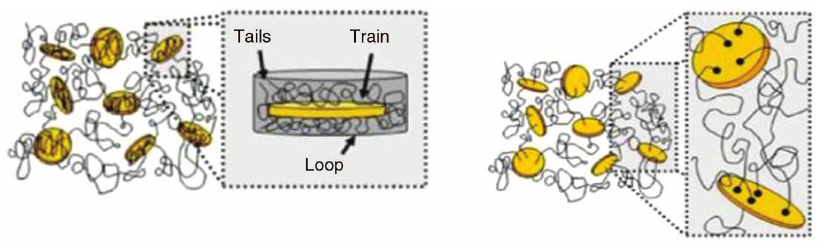
Figure 12: The polymer chains crosslinked with the nanosilicate particles. Ref. [34], (© Springer-Verlag 2008) “with permission of Springer”.